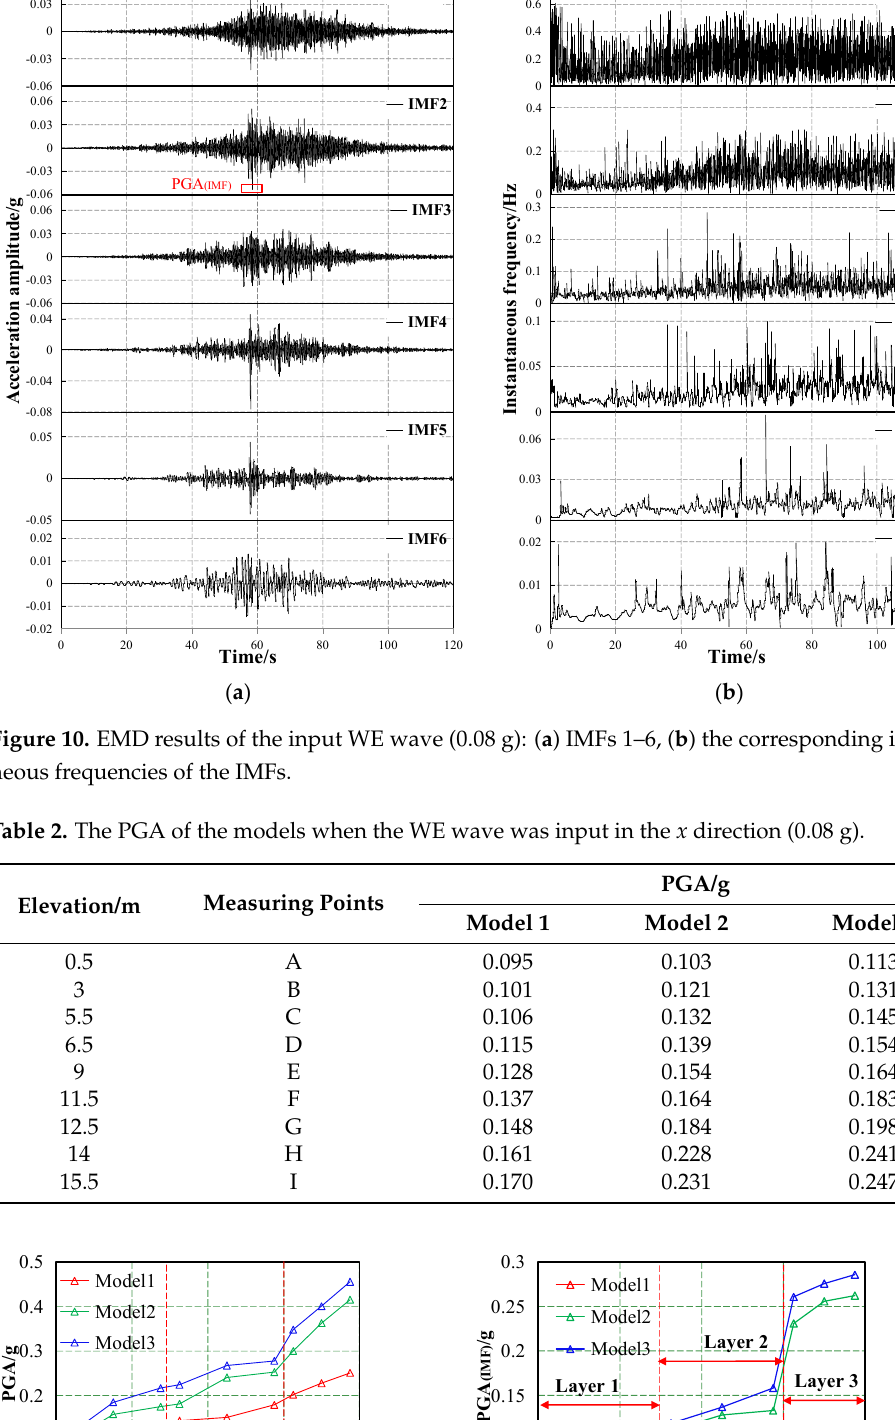
Table 2. The PGA of the models when the WE wave was input in the x direction (0.08 g).